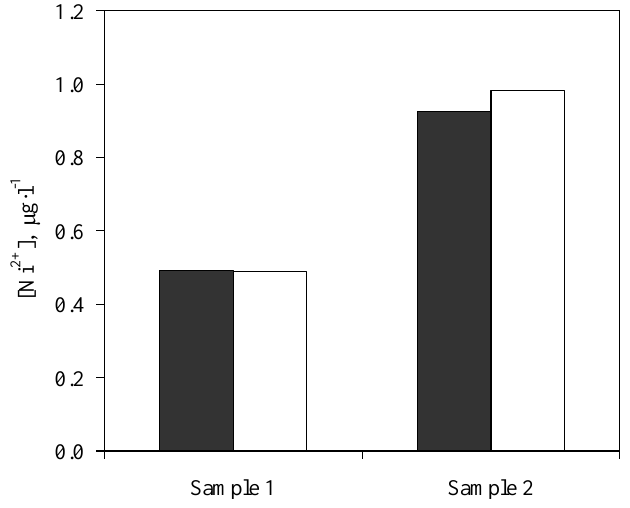
Figure 4. Free nickel concentration in saline waters. ( ■ ) Experimental data, (□) theoretical data .